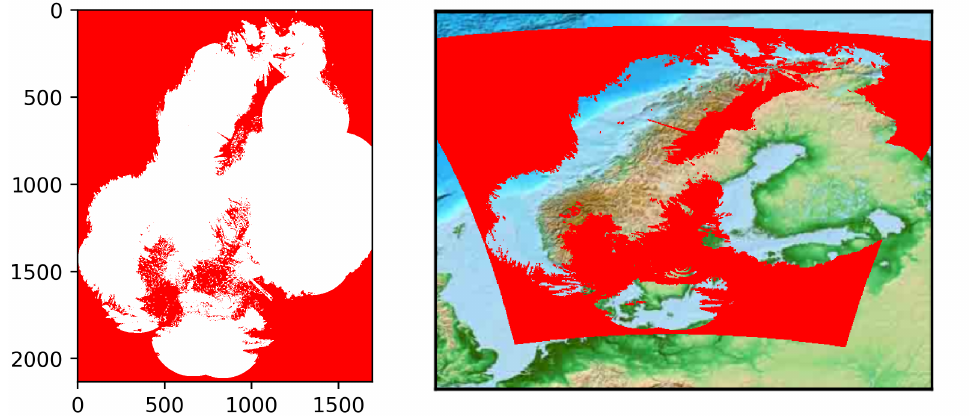
Figure 6. A visualization of data points that are missing for all acquisitions during a day from the MET dataset. Each pixel in the picture represents 288 data points (all acquisitions during a day). A pixel is colored in red when the data were missing for the entire day at that pixel. On the left, there is a visualization of the data matrix; on the right, there is a visualization of the data projected onto a